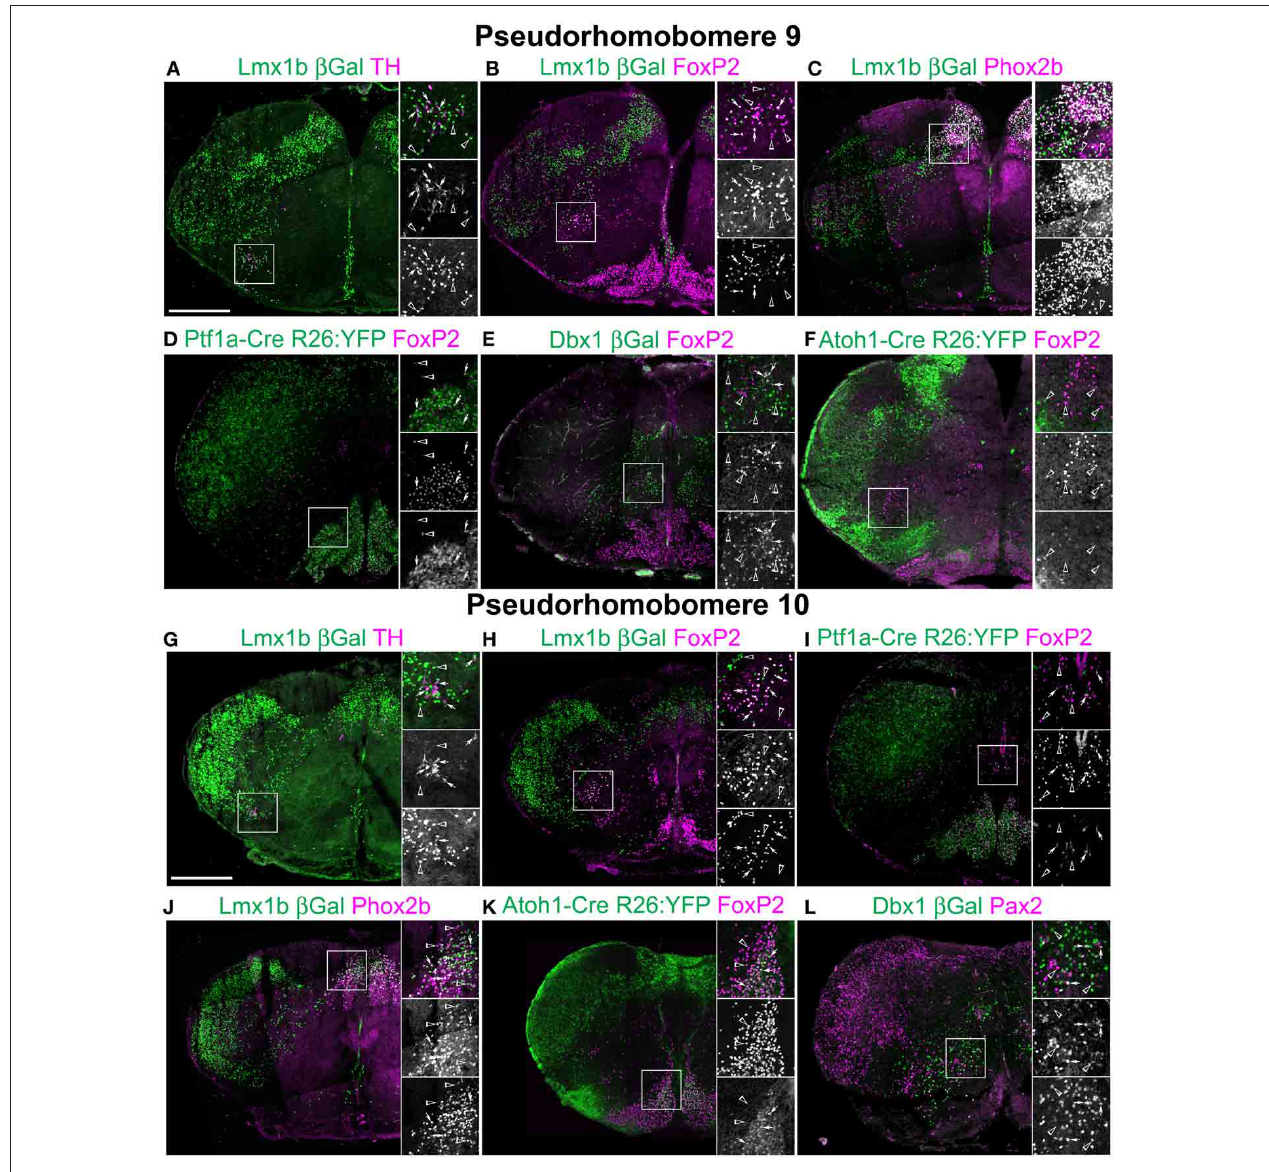
FIGURE 4 | Segmental organization of combinatorial patterns of gene expression within caudal medullary hindbrain lineages. Pseudo-color fluorescent confocal mosaic hemi-sections from P0 transgenic mice at the level of pseudo-rhombomere9 (A–F) and 10 (G–L) . Images from Lmx1b- β gal (A–C,G,H,J) , Ptf1a -Cre; R26YFP (D, I) Dbx1- β gal (E,L) , and Atoh1 -Cre;R26YFP